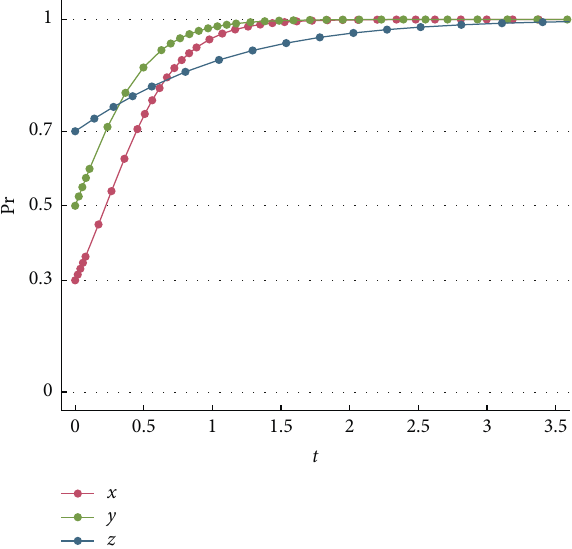
Figure 7: The final evolution result of E strategy.